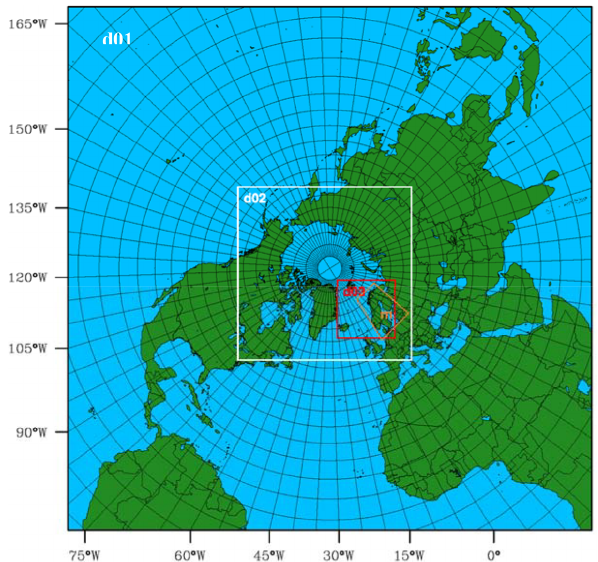
Figure 1. The study area as defined by the three domains used in the DEHM model (d01–d03) and the domain used in the MATCH model